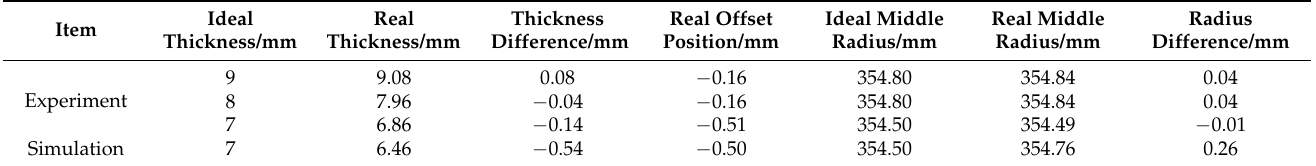
Table 1. The shape parameters of the different ACRFF tubes.